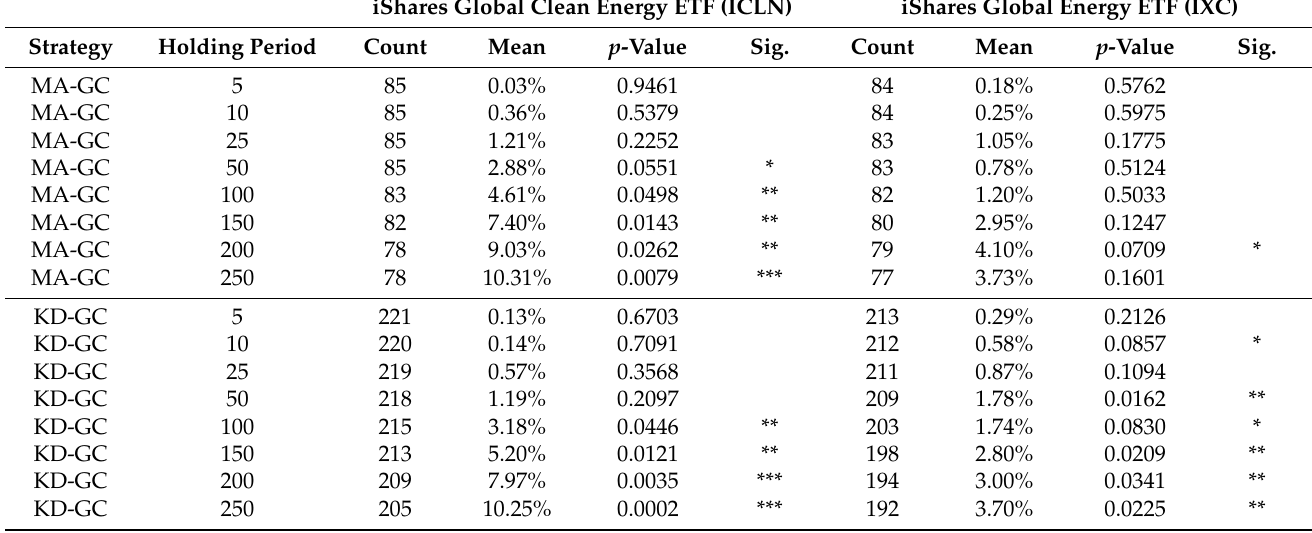
Table 3. Momentum strategies for trading energy-related ETFs according to MA and KD trading rules. By employing the financial commodities closely related to the performance of green energy (iShares Global Clean Energy ETF and its stock symbol: ICLN) or traditional energy (iShares Global Energy ETF and its stock symbol: IXC) over the data period 2010–2021, we then investigate